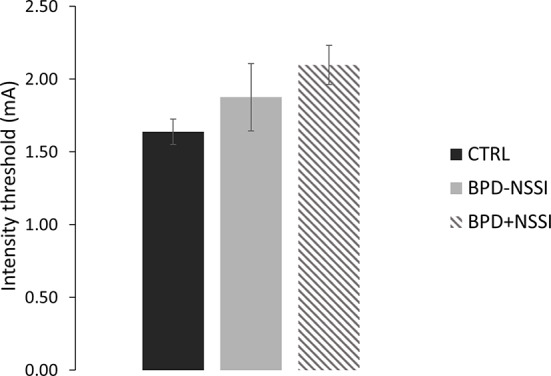
Threshold level. Separately for each group, the intensity stimulation (mA) is reported. Error bars indicate sem. (CTRL in black; BPD-NSSI in gray, and BPD+NSSI in gray diagonal lines pattern).